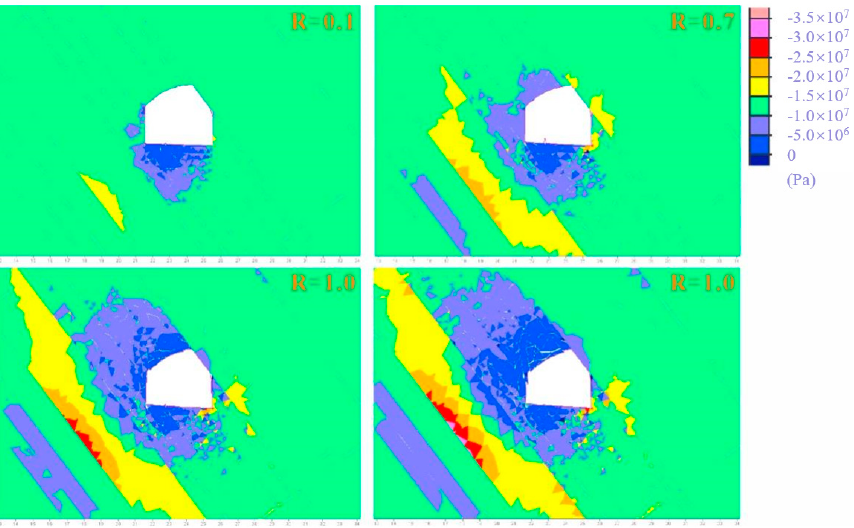
Figure 7. Nephogram of the maximum principal stress of the roadway during the stress release process.